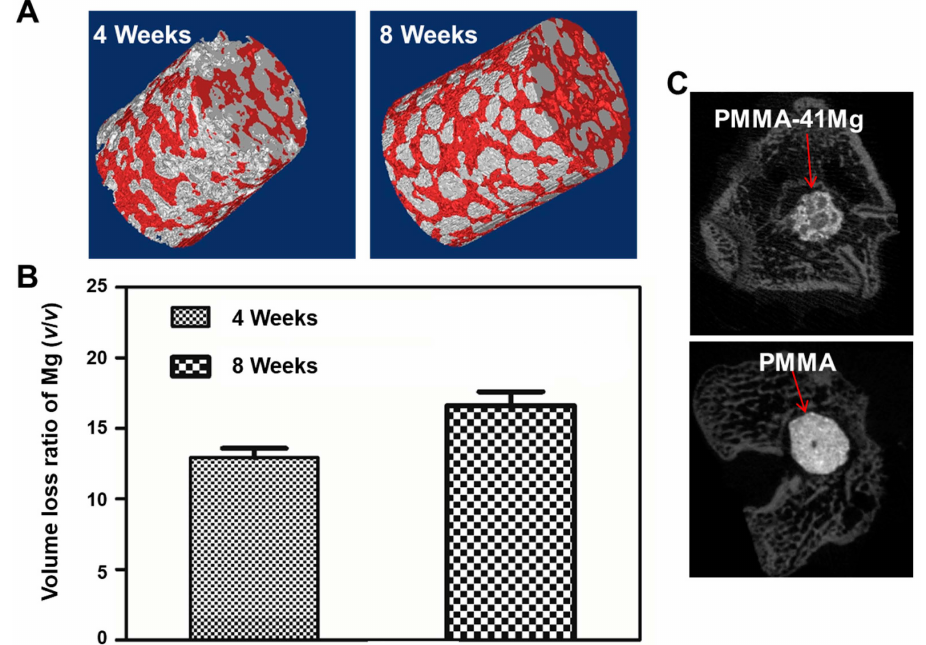
Figure 9. ( A ) Micro-CT reconstructed images of implanting during the four weeks and eight weeks (red indicates PMMA and gray indicates Mg microspheres); ( B ) volume loss ratio of Mg and ( C ) micro-CT images of PMMA–41Mg and PMMA after implantation for eight weeks.